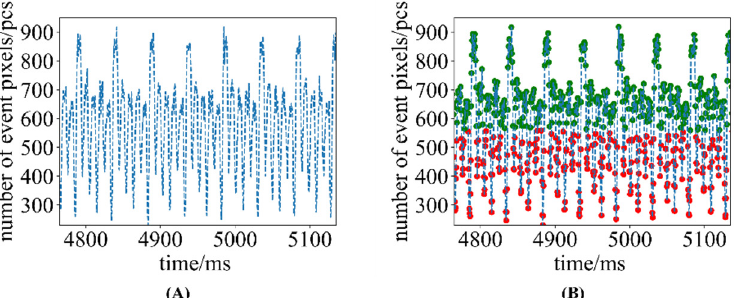
Figure 8. Illustration of the selection strategy. ( A ) is the change in the number of event pixels in the ROI over time when the fan rotates. ( B ) is the result of using the Gaussian Mixture Model to separate out event slices containing letters. We discard invalid event slices that do not contain letters, and select only one event slice per letter for recognition.